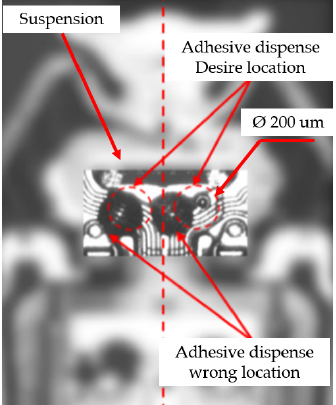
Figure 5. Adhesive dispensing in the wrong position.